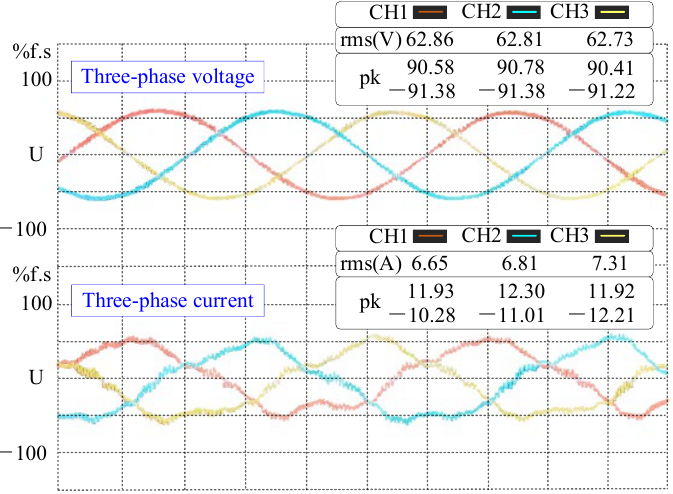
Figure 14. Measured three-phase currents and voltages at the rated condition. The input current and input voltage are measured at 17.2 Hz. The measured wave- forms are shown in Figure 15a. The RMS values of the three-phase input voltage are 62.86 V, 62.81 V, and 62.73 V, respectively. The RMS values of the three-phase input current are 6.65 A, 6.81 A, and 7.31 A, respectively.